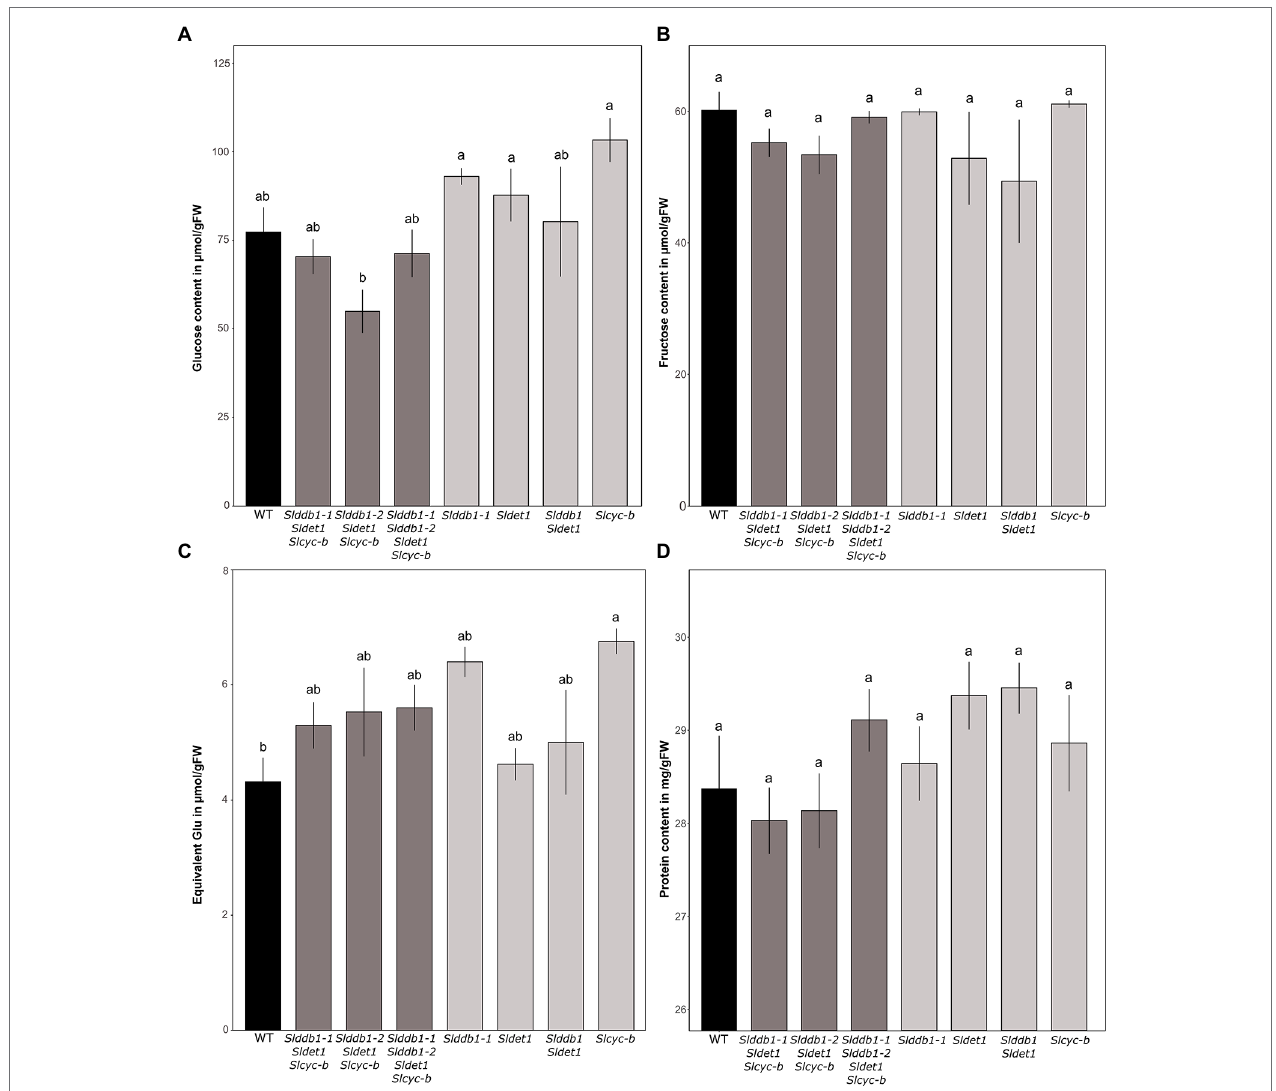
FIGURE 6 | Sugar contents in μ mol.g − 1 FW and protein contents of segregating T 3 and BC 1 F 3 generations at the red ripe stage. (A–C) Measurement of glucose, fructose and sucrose contents in the fruit pericarp by spectrophotometry at 12 DPB in T 3 and BC 1 F 3 segregants, respectively. Concentrations are expressed in μ mol. g − 1 FW for glucose and fructose and equivalent glucose in μ mol.g − 1 FW for sucrose. (D) Protein content measured at 12 DPB in T 3 and BC 1 F 3 segregants. The content is expressed in mg/gFW. Black indicates WT, dark gray indicates T 3 triple mutant lines, and light gray indicates BC 1 F 3 segregants. Error bars indicate SD, and letters and upper bars indicate groups significantly different at p = 0.05 according to the SNK